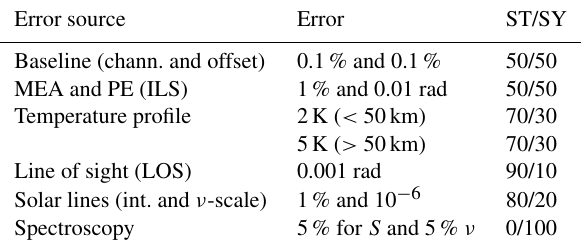
Table B1. Error sources and assumed values used in the theoreti- cal uncertainty estimation. The last column shows the contributions of statistical (ST) and systematic (SY) sources to the total